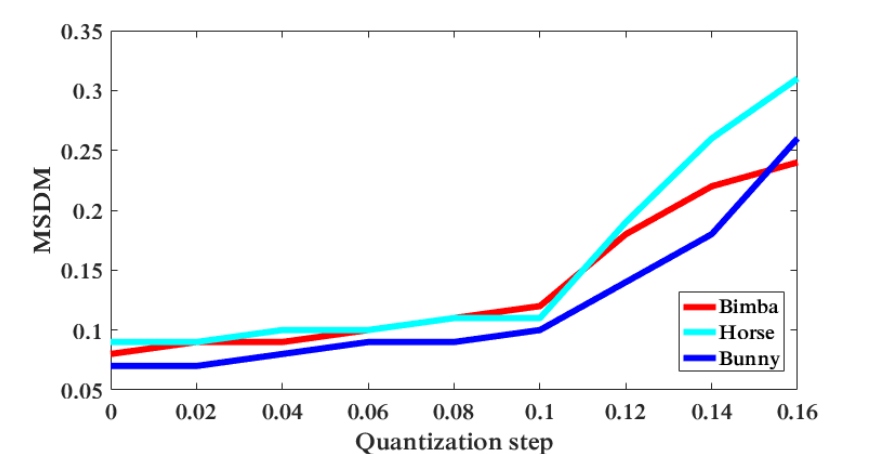
Figure 8. The imperceptibility performance in terms of MSDM using several quantization steps for Bimba, Horse, and Bunny